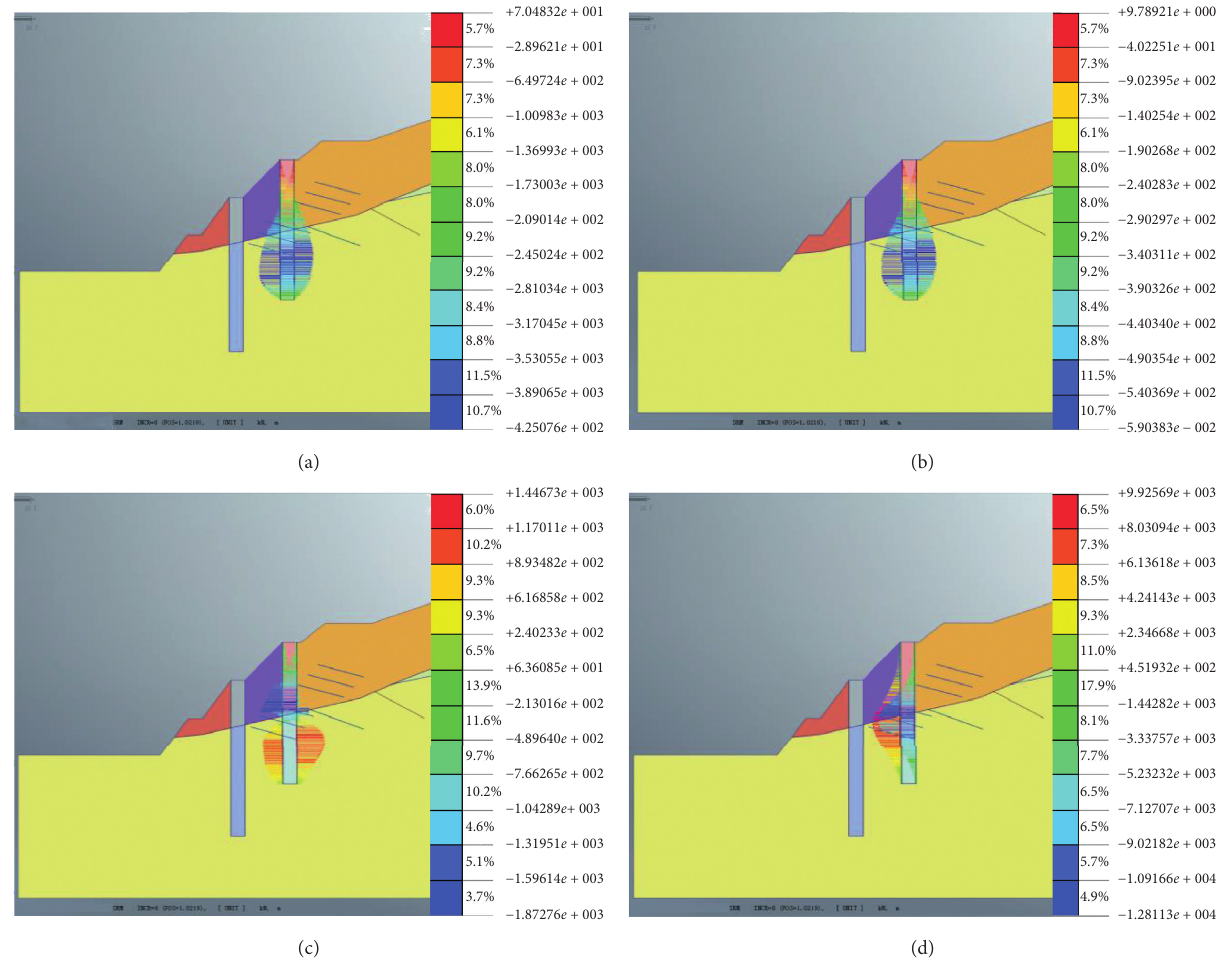
Figure 9: Stress cloud diagrams of antislide piles without considering steady-state seepage. Cloud maps of antislide pile: (a) axial force; (b) axial stress; (c) shear; (d) bending moment.